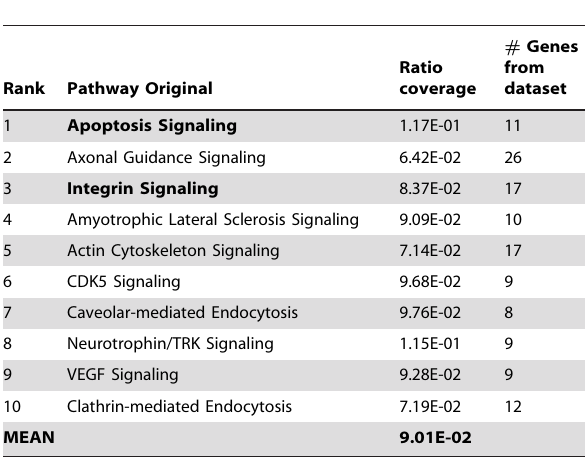
Top 10 of significant pathways identified by Ingenuity Pathway Analysis for the original whole microarray dataset. Pathways in bold were found in the top 10 series of both the original and re-annotated datasets. Ratio Coverage = the number of genes from the data set that map to the pathway divided by the total number of genes that map to the canonical pathway is displayed (Ingenuity H Systems).